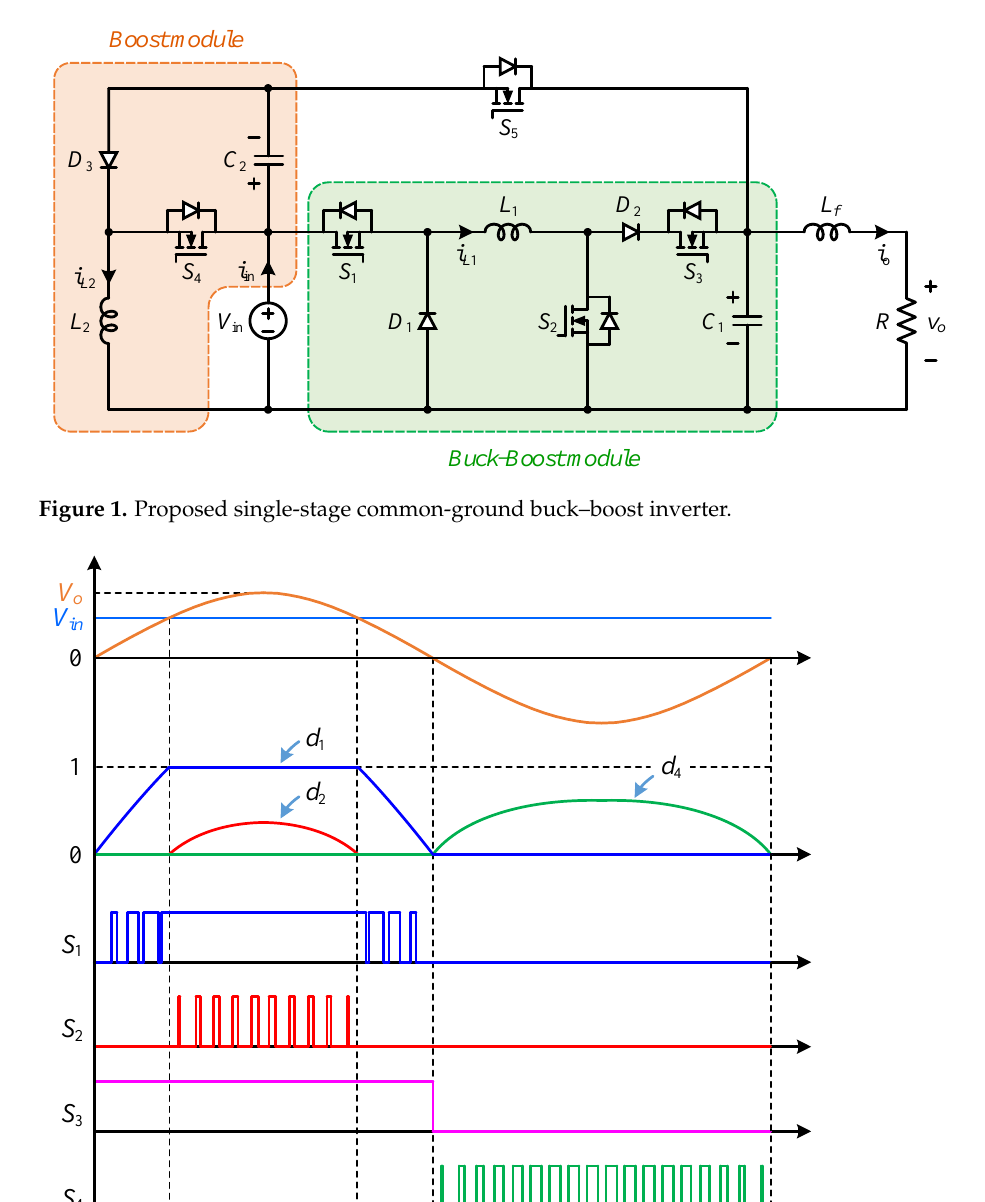
Figure 1. Proposed single-stage common-ground buck – boost inverter.